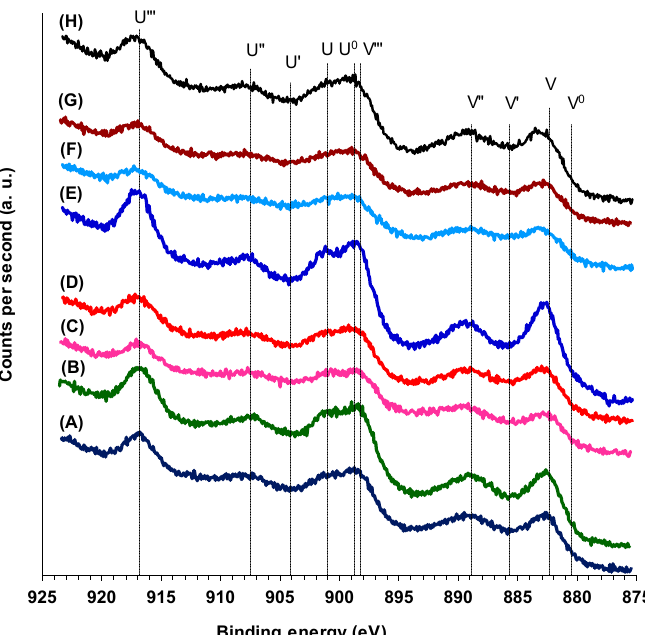
Figure 6. Ce 3d core levels XPS spectra of the mixed oxides: CuCeMgAlO (A), Mn(3)CuCeMgAlO (B), Fe(3)CuCeMgAlO (C), Co(3)CuCeMgAlO (D), Ni(3)CuCeMgAlO (E), Co(1)CuCeMgAlO (F), Co(6)CuCeMgAlO (G), Co(9)CuCeMgAlO